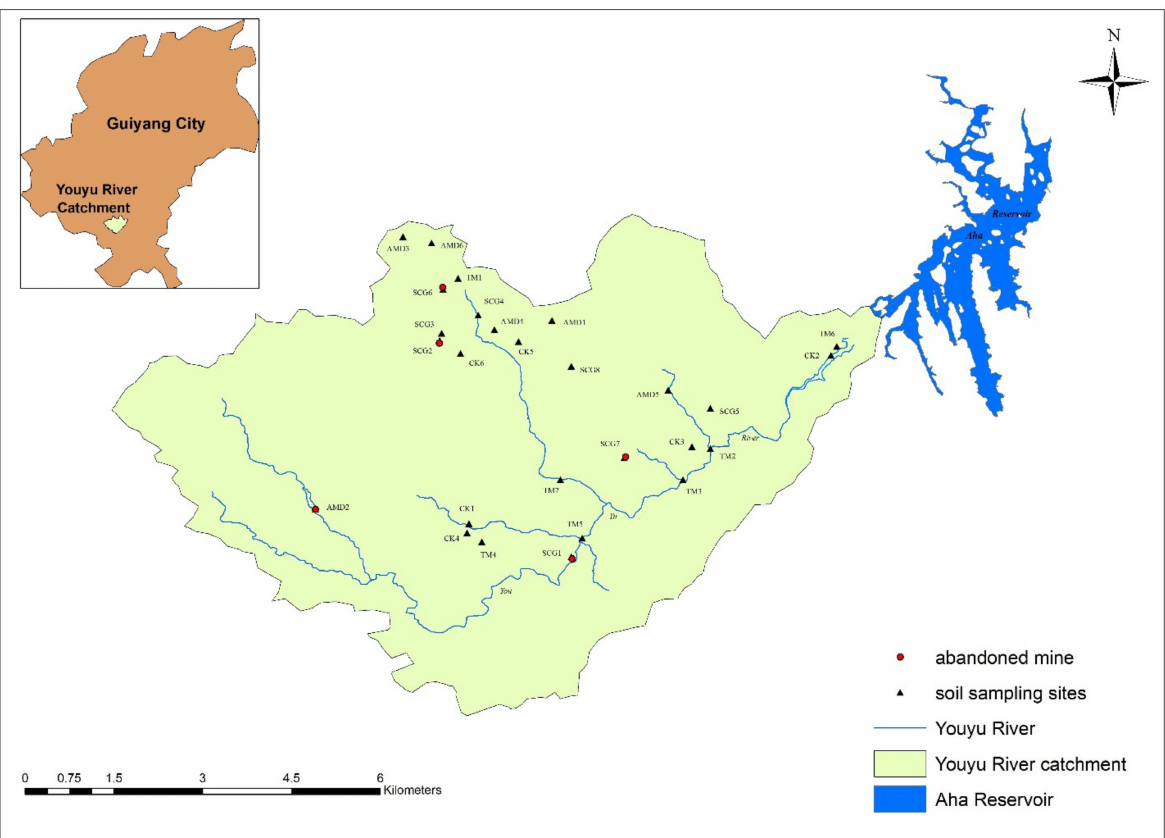
Figure 1. Locations of sampling sites in the studied